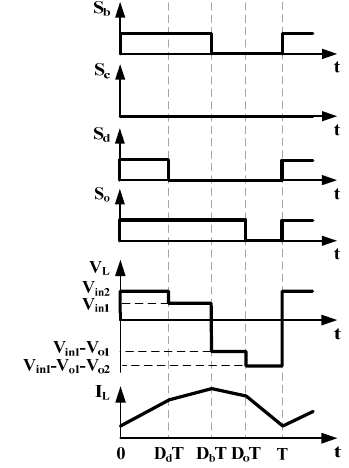
Figure 2. Steady ‐ state waveforms of the proposed power converter in the battery discharging mode.